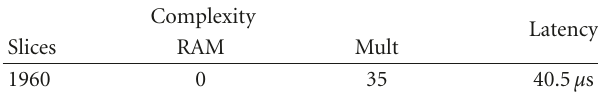
Table 1: Complexity evaluation of the WiFi